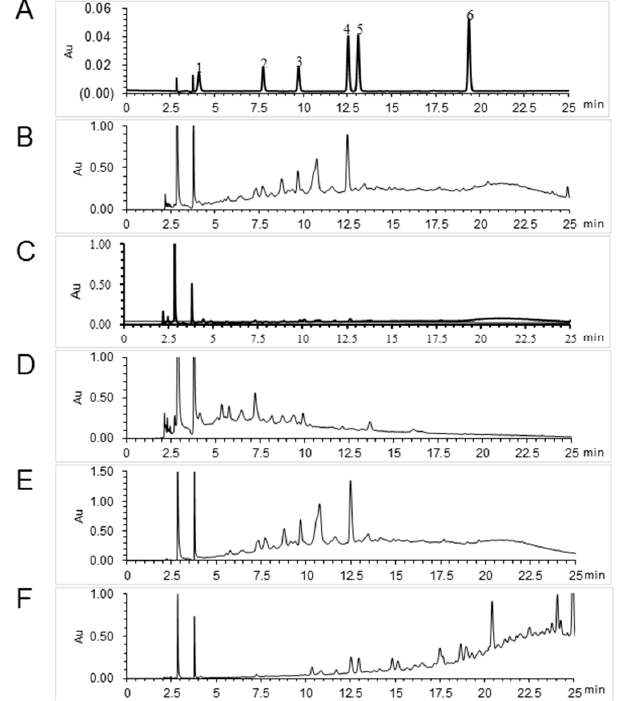
Figure 6. Chromatogram of the representative constituents in the water extract of S. suberectus and sub-fractions obtained from macroporous resin with gradient ethanol elution. ( A ) Mixed standard solution of gallic acid (1); epigallocatechin (2, EGC); catechin (3); epicatechin (4, EC); epigallocatechin gallate (5, EGCG), and epicatechin gallate (6, ECG) at 2.50, 21.92, 10.67, 14.25, 7.64 and 11.75 μ g/mL, respectively; ( B ) Prepared samples of crude water extracts of S. suberectus , and sub-fractions eluted from macroporous resin by ( C ) 0%; ( D ) 25%; ( E ) 50%; and ( F ) 75% ethanol solutions at 41.28, 23.72, 33.46, 33.70, and 31.75 mg/mL, respectively.